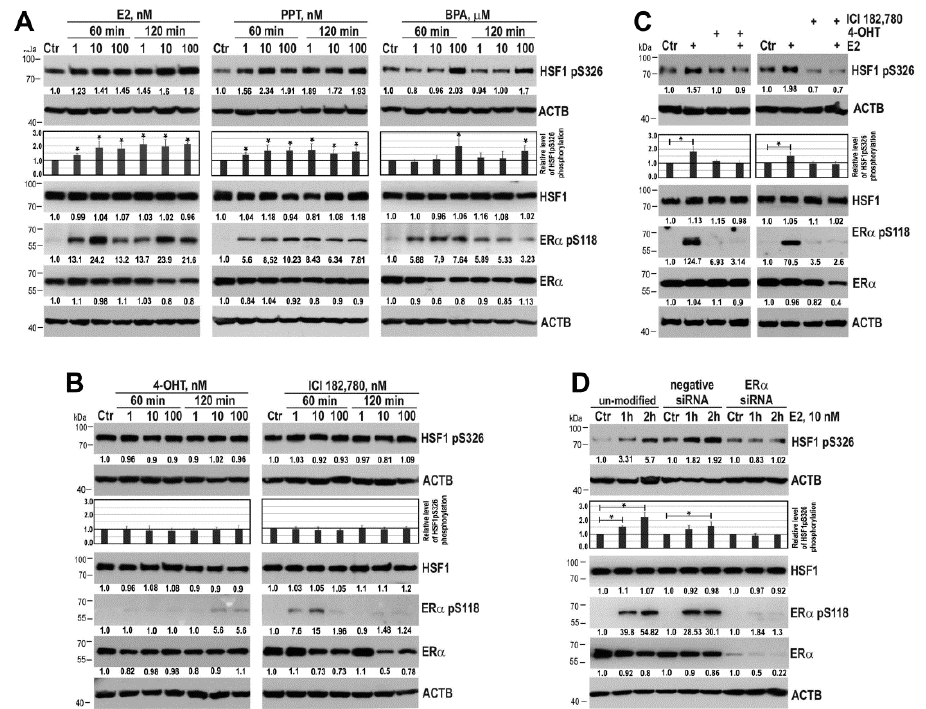
Figure 2. ER α is indispensable for HSF1 phosphorylation on S326 in MCF7 cells. ( A ) An influence of ER α agonists (E2, PPT, BPA) and ( B ) E2 antagonists (4-OHT and ICI 182,780) on HSF1 phosphorylation. ( C ) E ff ect of E2 on HSF1 phosphorylation after pretreatment of cells with 4-OHT or ICI 182,780 (added at concentration 100 nM for one hour before treatment with 10 nM E2 for one hour or two hours, respectively). ( D ) E ff ect of E2 on HSF1 phosphorylation in cells with down-regulated ER α . ER α phosphorylation on S118 was used as a marker of ER α activation, and ACTB was used as a protein loading control. The results of densitometric analyses are shown in the charts. An asterisk indicates a significant di ff erence ( p < 0.05) from the control (Ctr) value. Numbers below blots represent protein bands’ intensity ratios to adequate controls after normalization against ACTB.